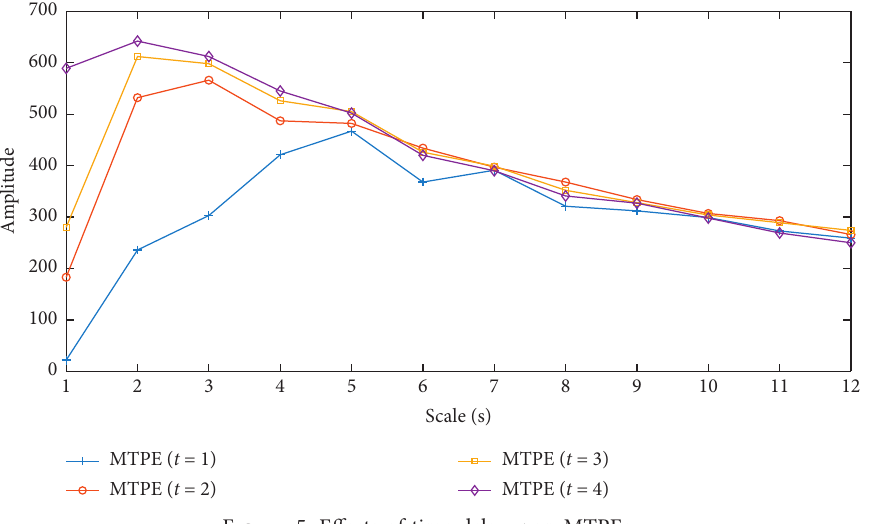
Figure 5: Effects of time delay τ on MTPEs.